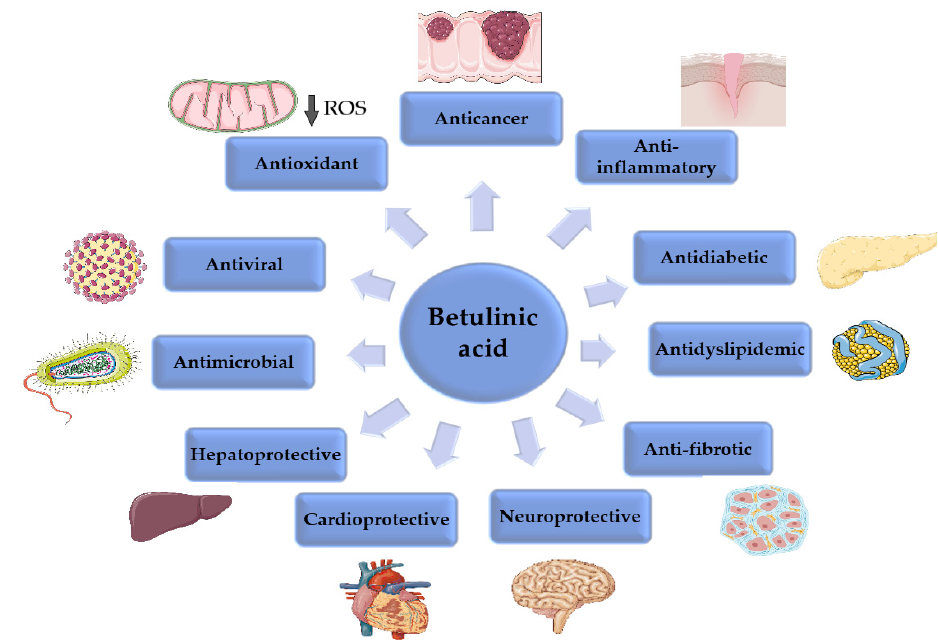
Figure 3. Biological activities of betulinic acid. Parts of the figure were drawn by using